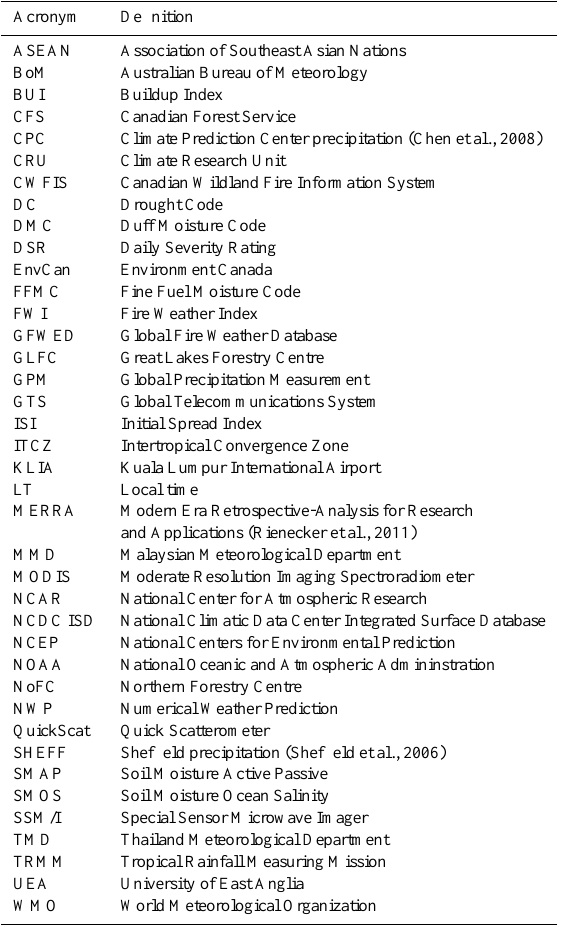
Table 1. Acronyms used in the